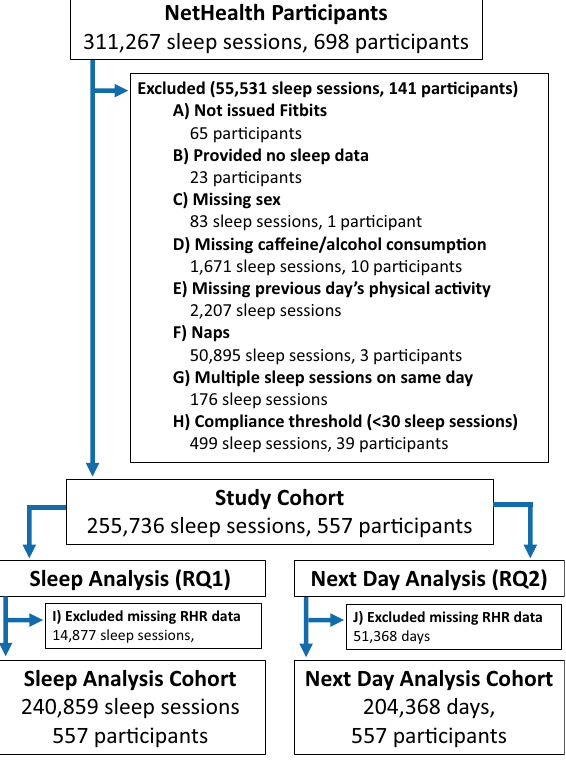
Fig. 3 Flow diagram. Outline of cohort selection and data pre- processing steps with the number of participants/data points removed at each